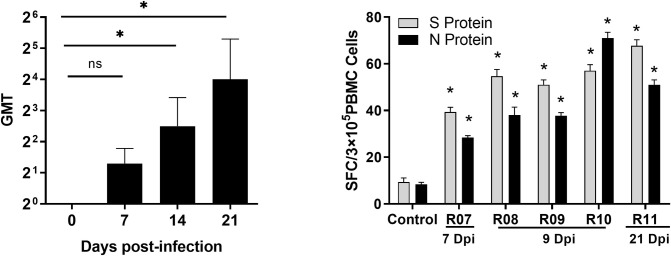
Neutralizing antibody level and ELISpot analysis of rhesus macaques infected with SARS-CoV-2.(A) Neutralizing antibodies against SARS-CoV-2 were titered on Vero cells at 100 TCID50 virus. (B) S and N protein-specific IFN-γ+ secretion T cells were numbered on precoated PVDF plates by an ELISpot reader. Compared with controls,”*”, p<0.05; “ns”, p>0.05.